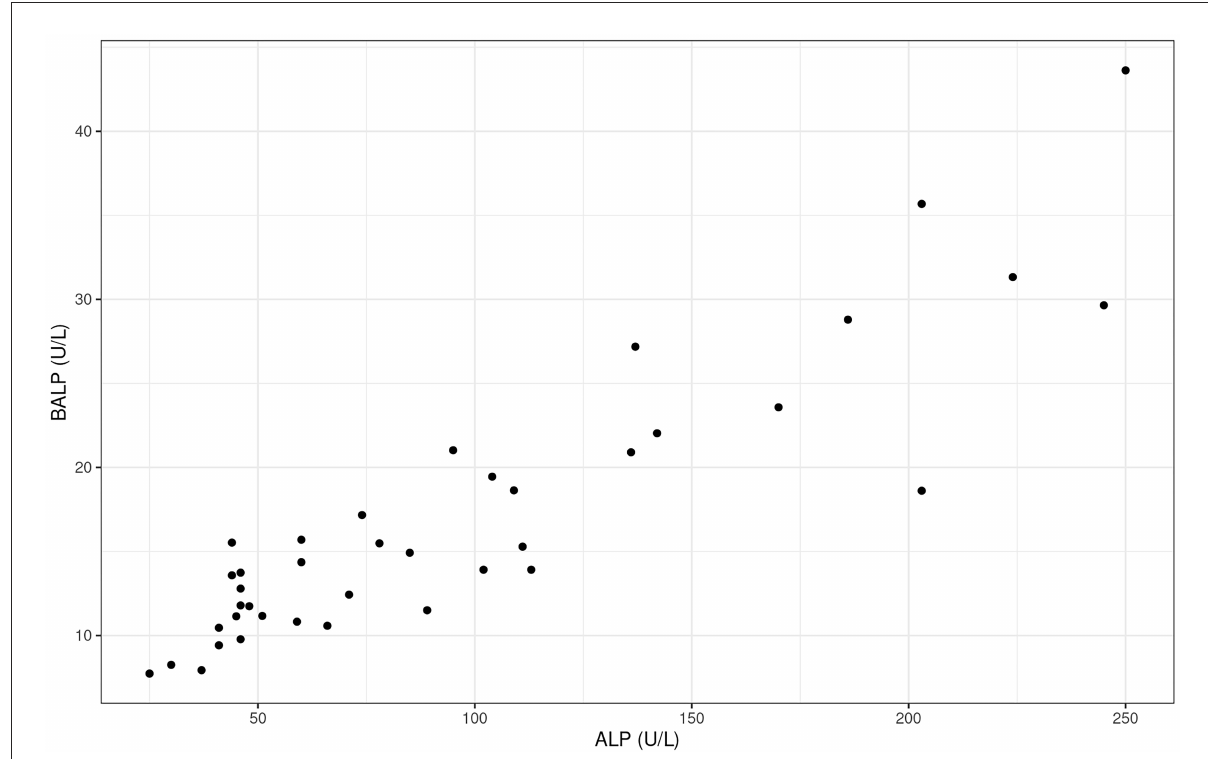
FIGURE6 Scatter plot to depict the strong positive correlation between total activity levels of bone-specific alkaline phosphatase (BALP; U/L) and alkaline phosphatase (ALP; U/L) in dogs dosed with CBD at the 26-week time point ( r = 0.9).